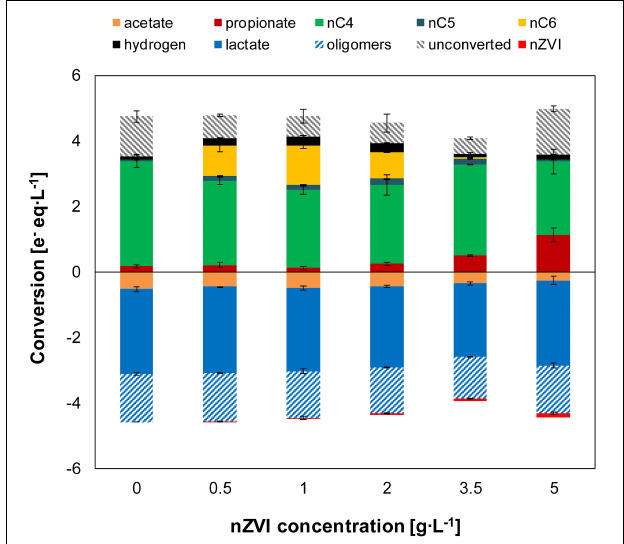
FIGURE 3 | Experiment II—Net conversion by the end of the experiments at different nZVI concentrations. Oligomers were estimated as a fraction (0.36) of total lactate. The unconverted fraction shows missing electrons (from nZVI and oligomers) between metabolic products and substrates added (acetate, total lactate and Fe 0 ). Error bars show duplicates absolute deviation from